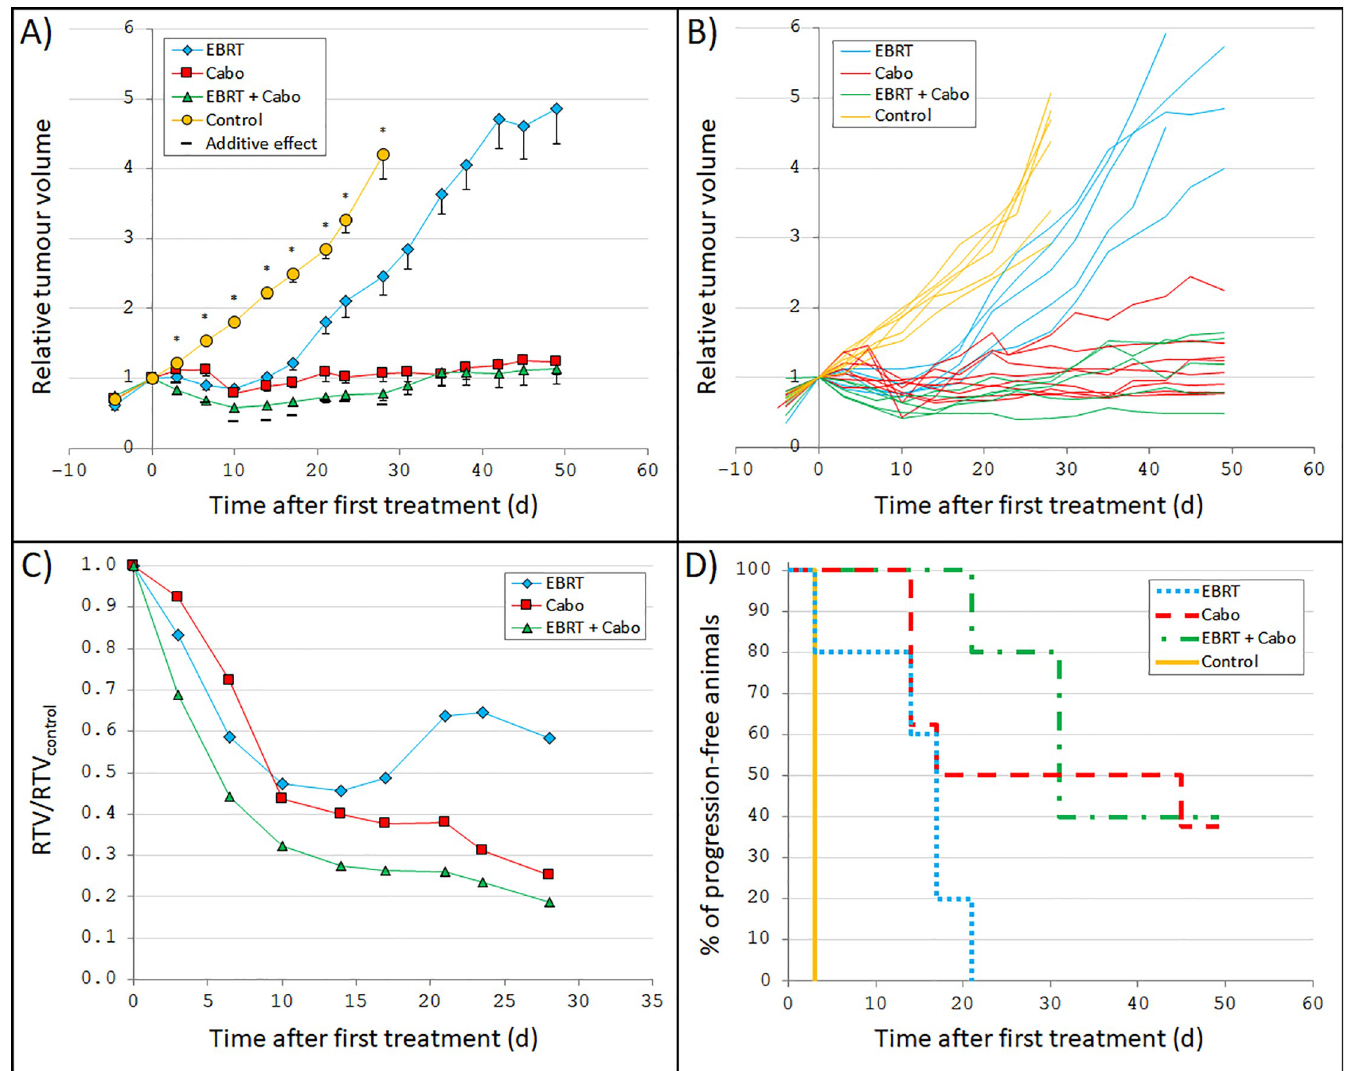
Fig 2. Tumour growth after radiation and/or cabozantinib treatment. Nude mice carrying GOT2 tumours were treated with external beam radiotherapy (EBRT), cabozantinib (Cabo), a combination of both, or mock-treated as control. The absorbed dose from EBRT (3 Gy in one exposure on day 0) and the amount of cabozantinib (50 mg/kg twice weekly) were chosen to give a moderate treatment effect to be able to detect any increased effect from combination therapy. (A) Mean relative tumour volume (RTV) vs . time after start of treatment. RTV was calculated as the tumour volume at a given time divided by the tumour volume at start of treatment. Included are also the corresponding calculated RTVs given a predicted additive effect (Eq. ((1)). Error bars represent SEM. The stars indicate that there was a statistically significant difference between the group means (ANOVA performed at day 3–28; p < 0.05). (B) Individual curves of RTV vs . time after start of treatment for each mouse. (C) Group-wise mean RTV compared with control (RTV/RTV control ) vs . time after start of treatment. Note the difference in x-axis scale. (D) Progression- free survival (percentage of animals without tumour progression) vs . time after start of treatment. Some lines end before they reach 0% because not all animals in these treatment groups had yet reached an RTV > 1 when the groups were